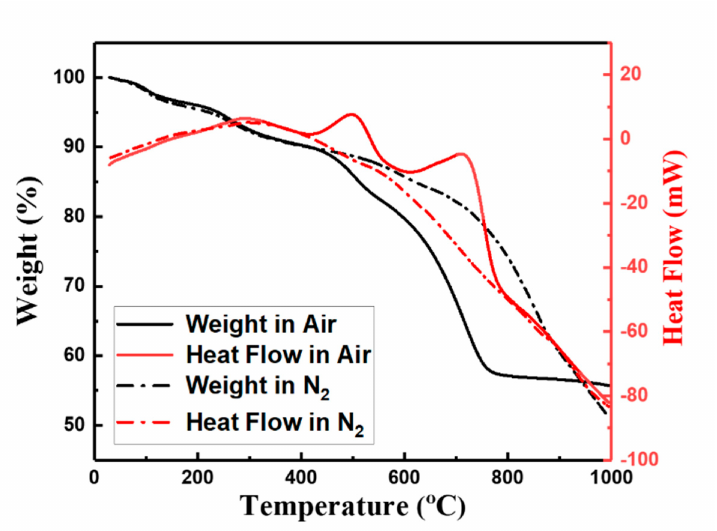
Figure 4. Thermogravimetric analysis in nitrogen and air